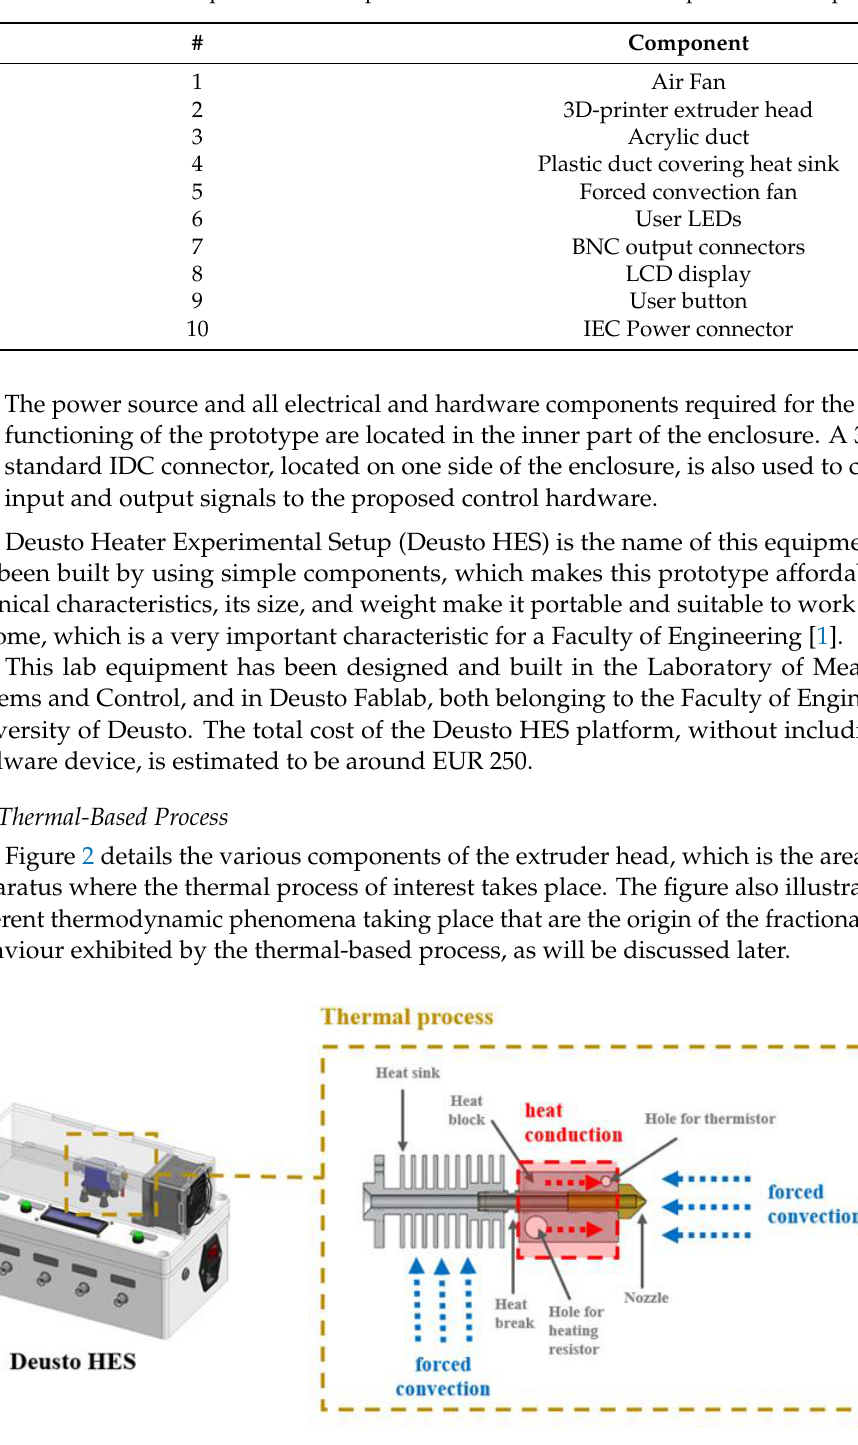
Figure 2. Deusto Heater Experimental Setup—Detail of the thermal process taking place in the extruder head.